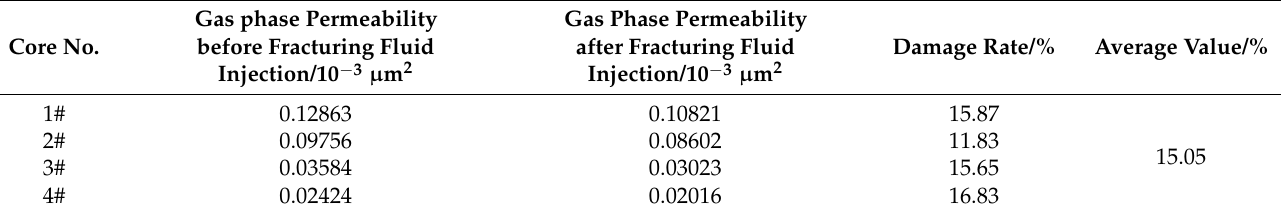
Table 8. Core damage performance of gel fracturing